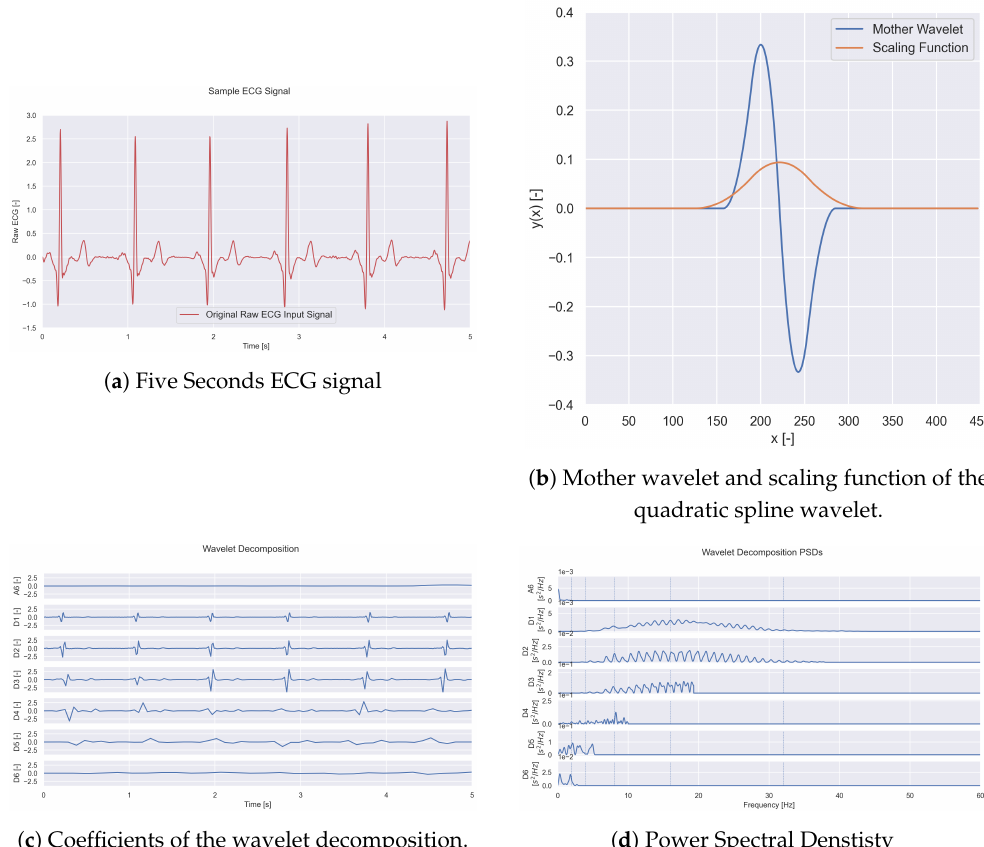
Figure 5. To compute he Power Spectral density ( d ) of the five-second ECG Signals ( a ), the signals were first decomposed until the sixth level ( c ) using the mother wavelet quadratic spline wavelet ( b ). The approximation (A6) and detailed (D1 to D6) coefficients of the wavelet were decompositions of a 5-second normal sinus rhythm. Finally, the Power Spectral Density of wavelet coefficients A6